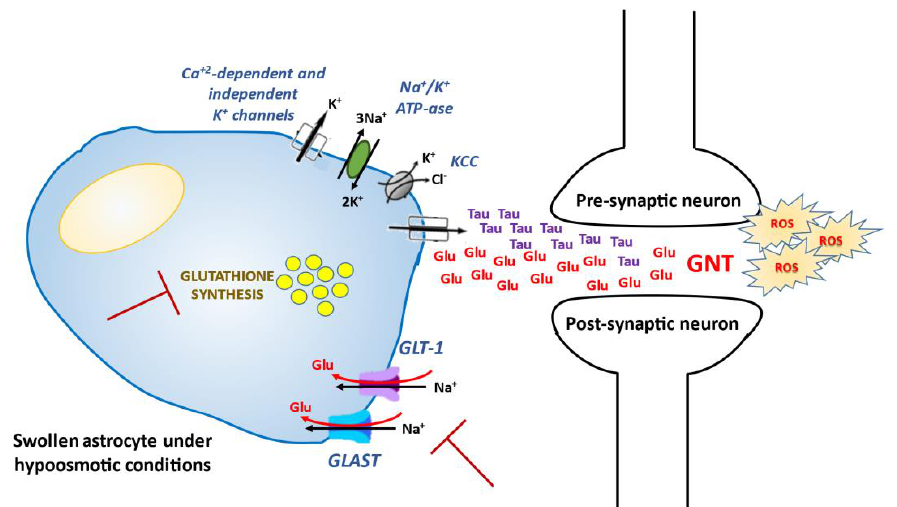
Figure 1. Non osmotically-induced effects of hyponatremia and oxidative stress. GLT-1 and GLAST: Na + -dependent glial glutamate transporters; ROS: reactive oxygen species; Glu: glutamate; Tau: taurine; GNT: glutamate neurotoxicity; KCC: K + /Cl − co-transporters.